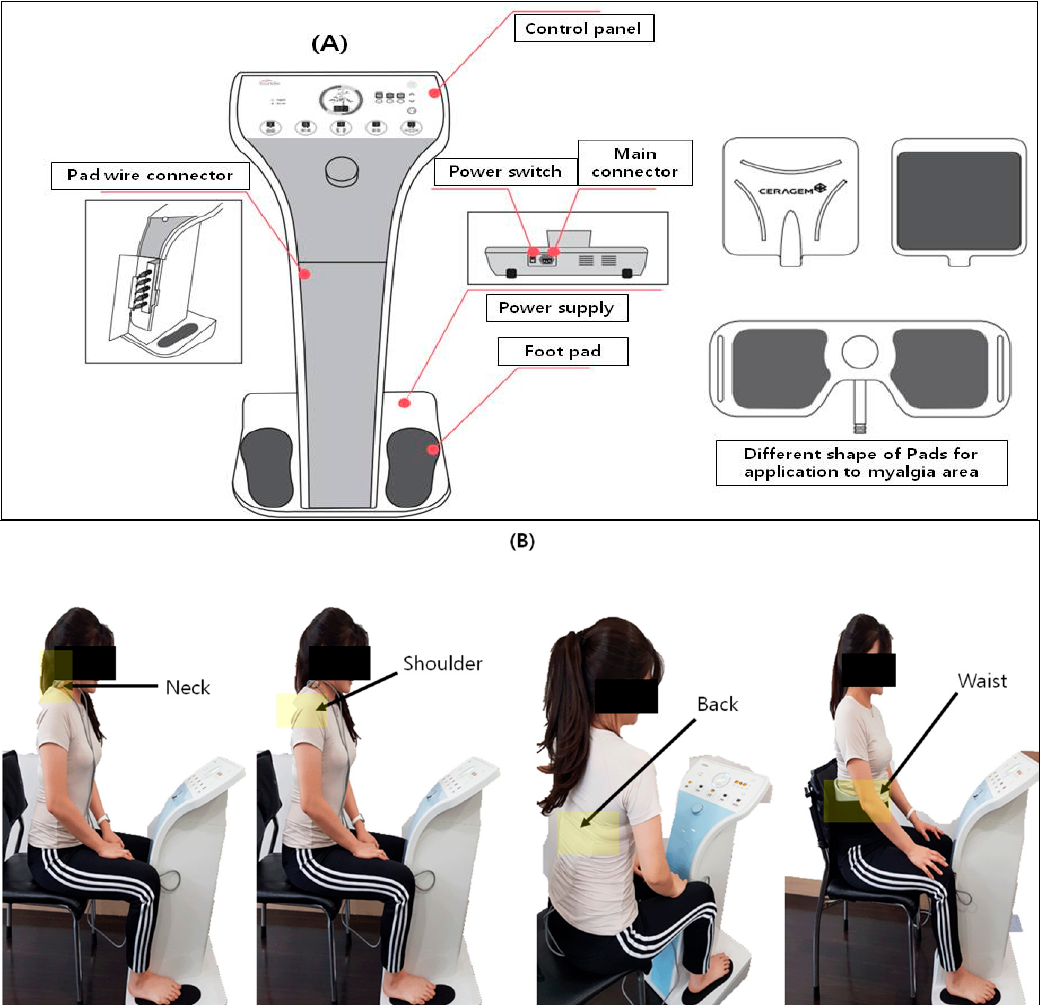
Figure 2. ( A ) Personal low-frequency stimulation device (CGM MBD-1201) and ( B ) clinical application of PLS on four different positions, such as the neck, shoulder, back, and waist.